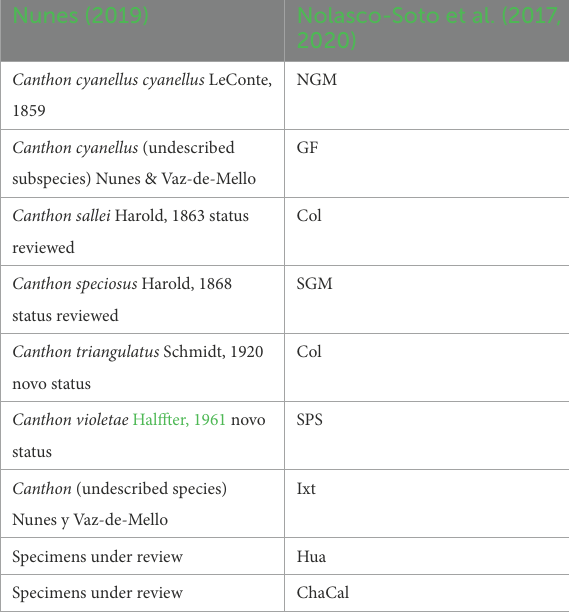
Clade code as in Table